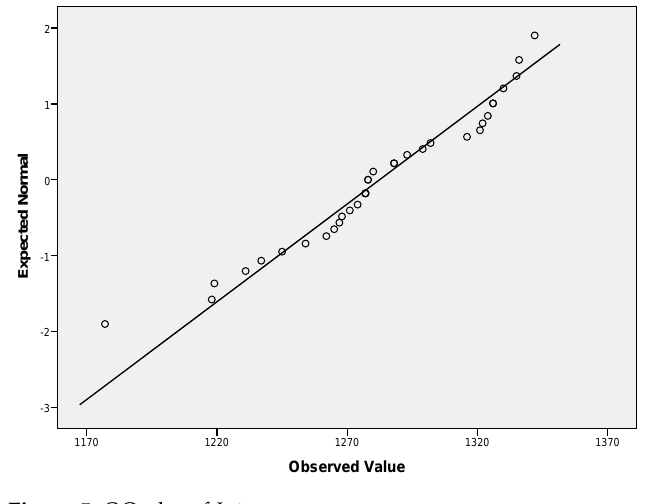
Figure 5. QQ plot of Int 3 ∗ . Table 8. Results of the Dunn and Tukey–Kramer post-hoc tests, α post =